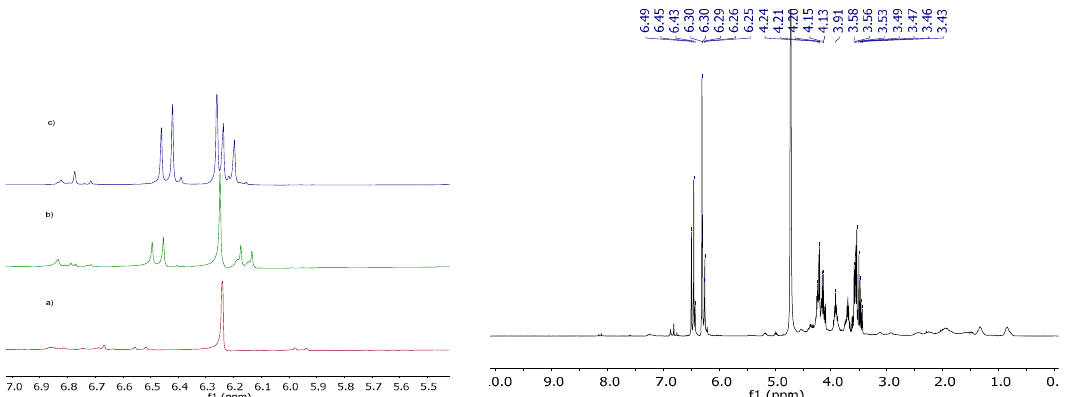
Figure 2. On the left are depicted part of the 1 H-NMR spectra of Bio-IA samples prepared with a) Bio-A/glycerol/MA = 70/15/15 wt %, b) Bio-A/glycerol/MA = 50/25/25 wt %, c) Bio-A/glycerol/MA = 30/35/35 wt % and on the right side, the full spectrum of Bio-IA.